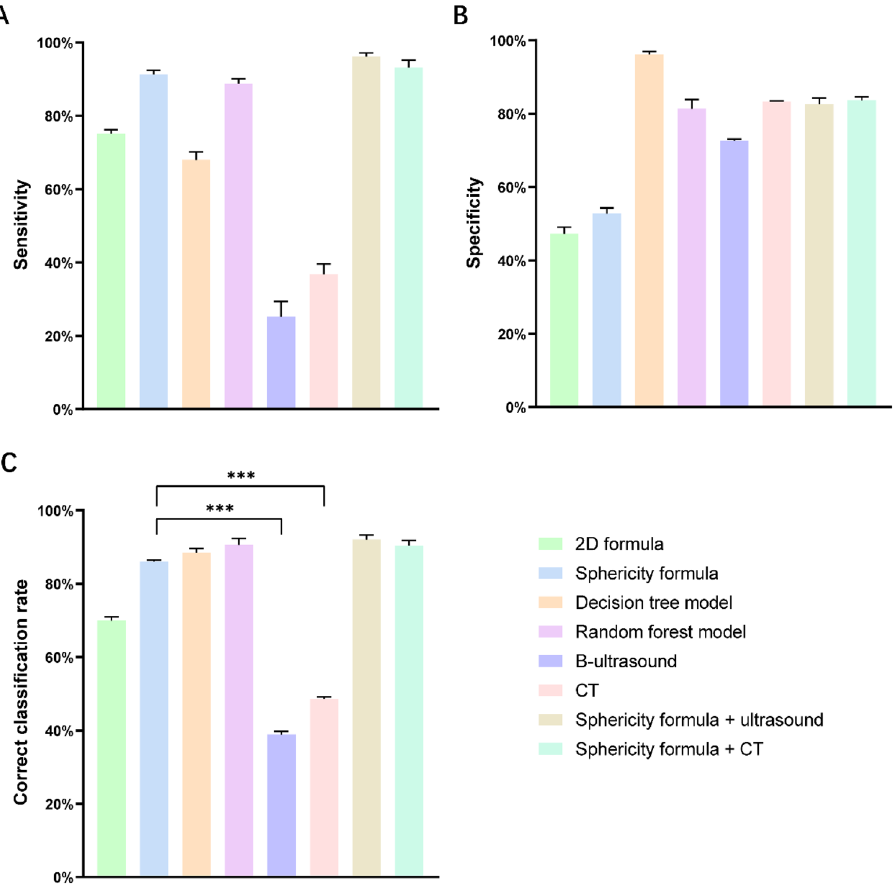
Figure 4. Comparison of the diagnostic efficacy of lymph node assessment methods. ( A ) and ( B ): Comparison of the sensitivity ( A ) and specificity ( B ) of various assessment methods for the diagnosis of lymph node metastases; ( C ): Comparison of correct classification rates for lymph node assessment methods. *** p < 0.0001 by the χ 2